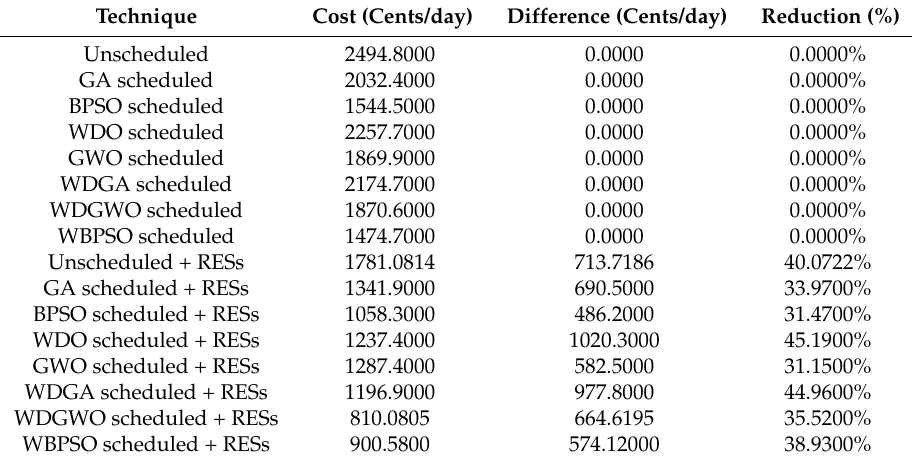
Table 13. Total cost of one day with and without